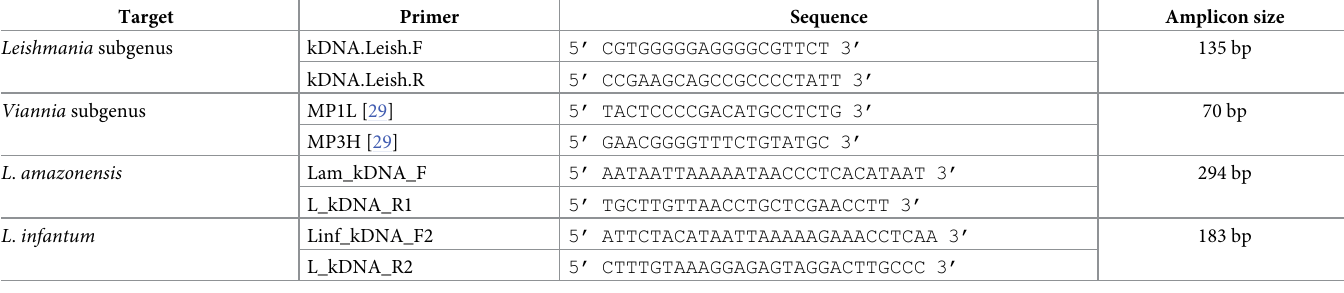
Table 1. Primers used in PCR reactions with their respective sequences and sizes of amplified products. Target Primer